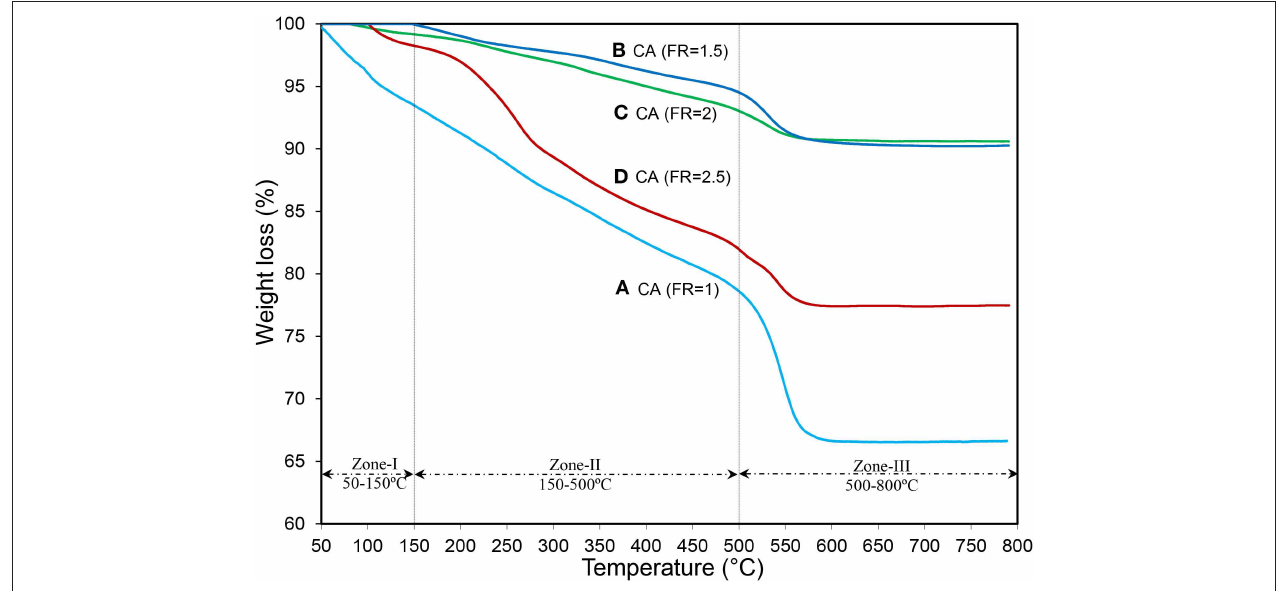
FIGURE 5 | TG analysis of synthesized CaAl 2 O 4 supports with various fuel ratios: (A) CA(FR = 1), (B) CA(FR = 1.5), (C) CA(FR = 2), and (D) CA(FR = 2.5).